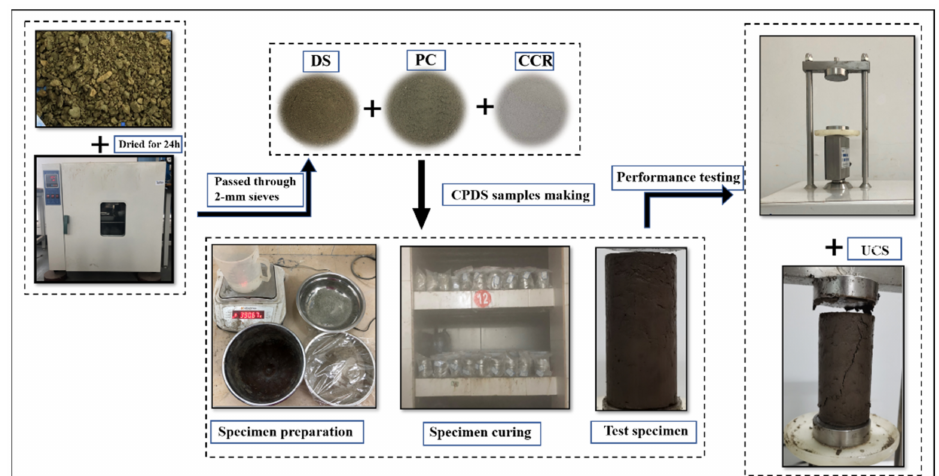
Figure 5. The preparation process of